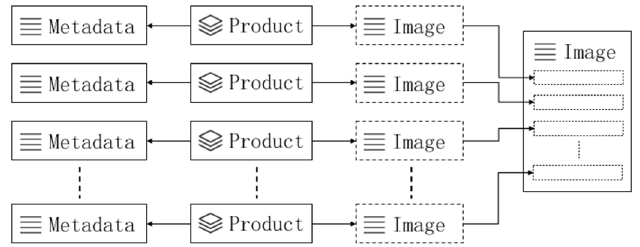
Figure 16. Overall storage schema of RSIMeta.